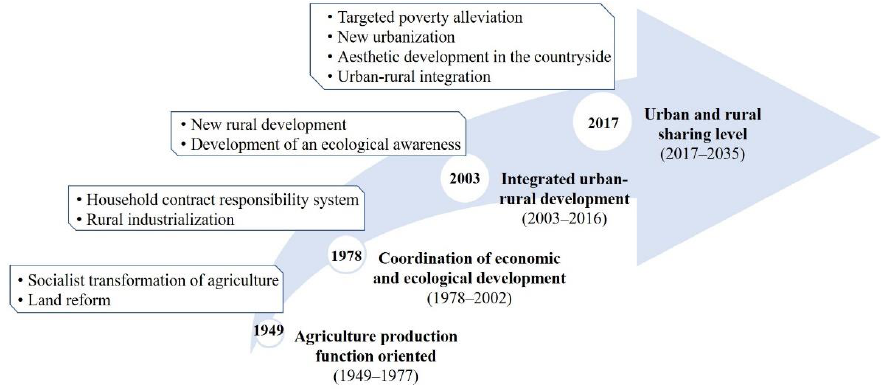
Figure 1. The stages characteristic of QRL in China from 1949 to 2035.